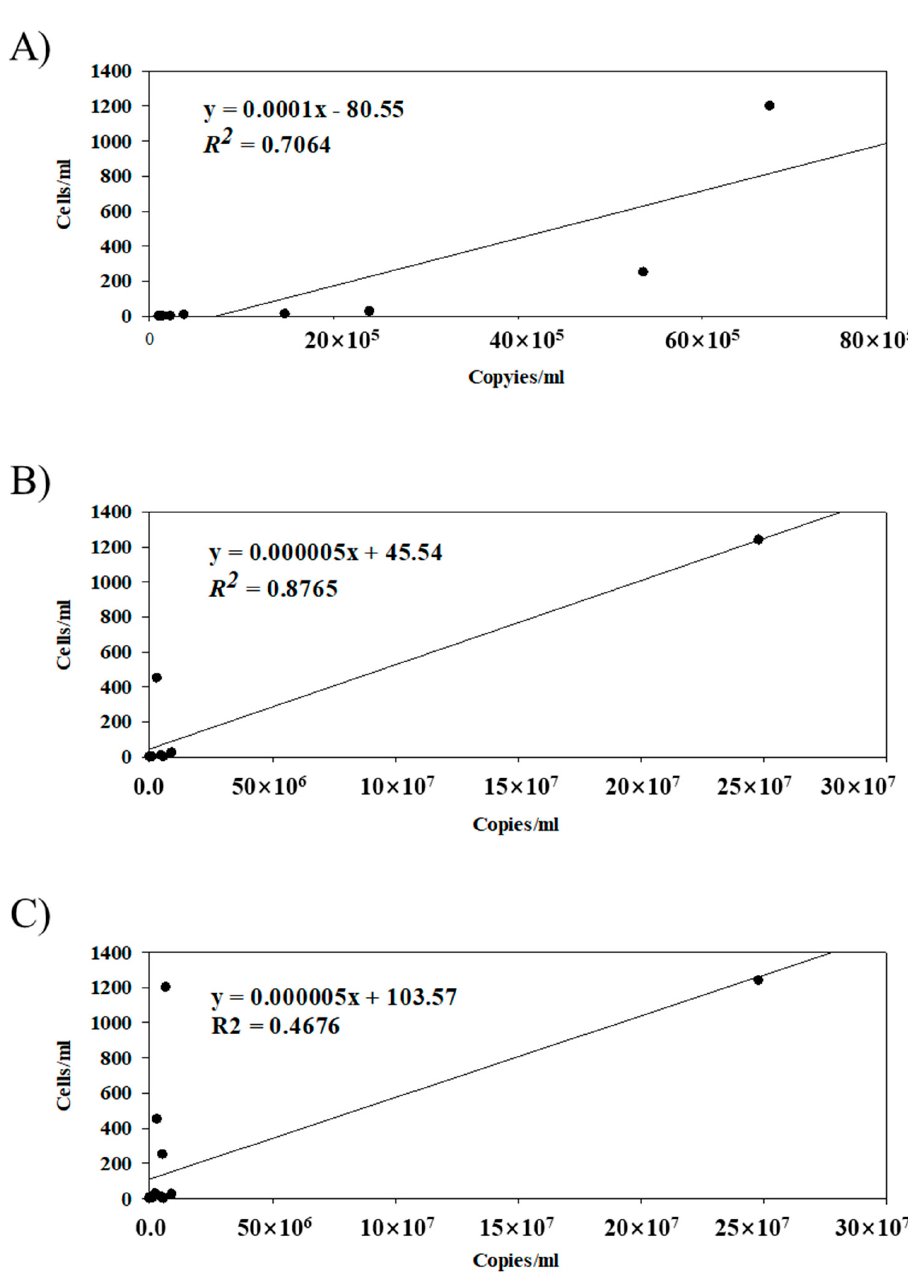
Figure 2. A linear relationship between copy numbers and cell numbers for C. polykrikoides . ( A ) 2018, ( B ) 2019, ( C ) 2018 and 2019 .